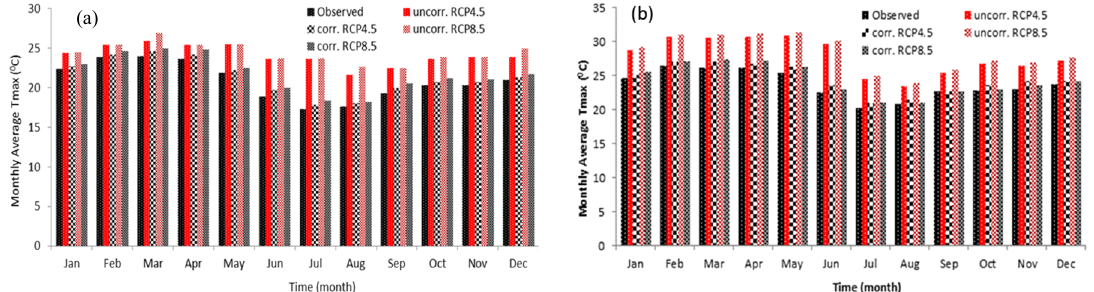
Figure 3. Bias corrected maximum temperature at ( a ) Addis Ababa and at ( b ) Debrazeit stations.